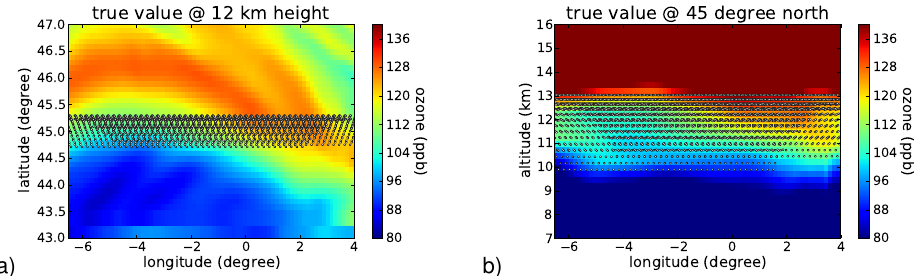
Fig. 3. The atmospheric situation and measurement geometry of the linear flight track numerical study. Panel (a) shows the true atmospheric state and the location of the tangent points at 12 km altitude. Panel (b) depicts the same for a vertical cutting plane at 45 ◦ N. The location of tangent points close to the depicted volume elements is indicated by small white circles.